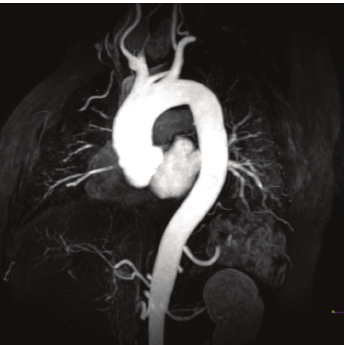
Figure 4: Aortic root ectasia is evident on 3D FSPGR MRI sequences obtained after gadolinium